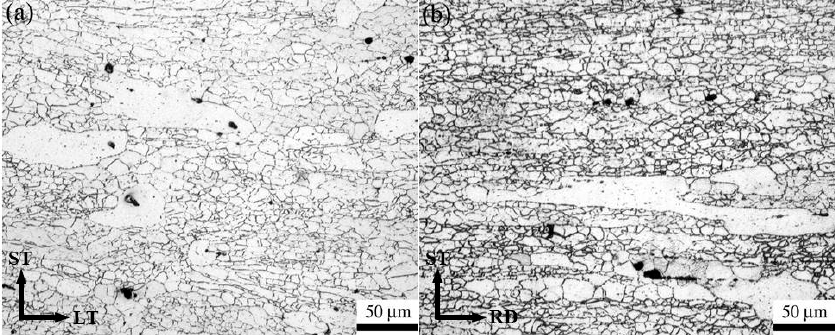
Figure 5. Optical micrographs showing microstructures of the over ‐ aged 7050 aluminum alloy in ( a ) the transverse plane; ( b ) the longitudinal plane.